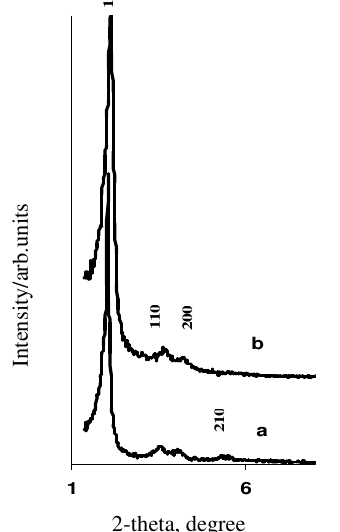
Figure 1. XRD patterns of a) LUS-1 b)Ti /LUS-1